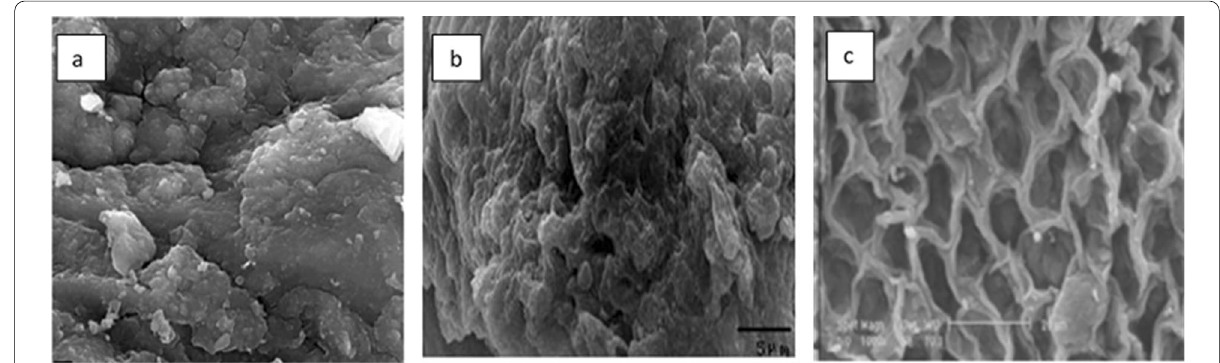
Fig. 1 SEM images of a alga Ulva lactuca (Ibrahim et al. 2016) , b dried Chlorella vulgaris (El-Sheekh et al. 2019), c E. intestinalis biomass (Boleydei et al.